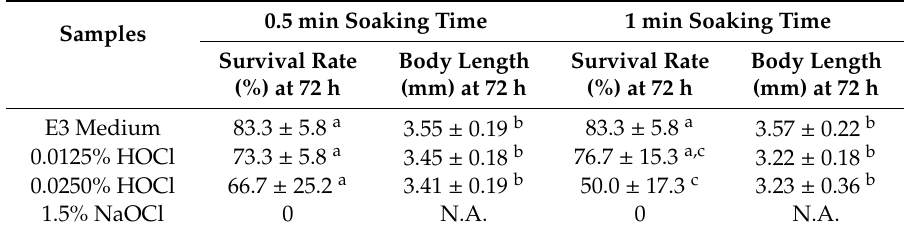
Table 2. Percent survival rate at 72 h of Zebrafish embryos after exposure to E3 medium, 0.0125%, and 0.0250%